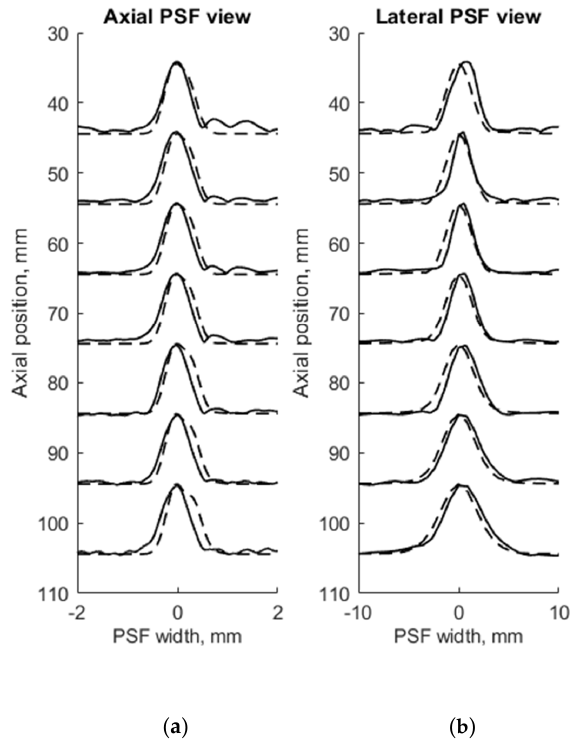
Figure 4. Comparison of the axial ( a ) and lateral ( b ) width of PSF: solid line—experimental echoscopy of physical wire phantom, dashed line—simulation of wire phantom by wires. PSF amplitudes were normalized.